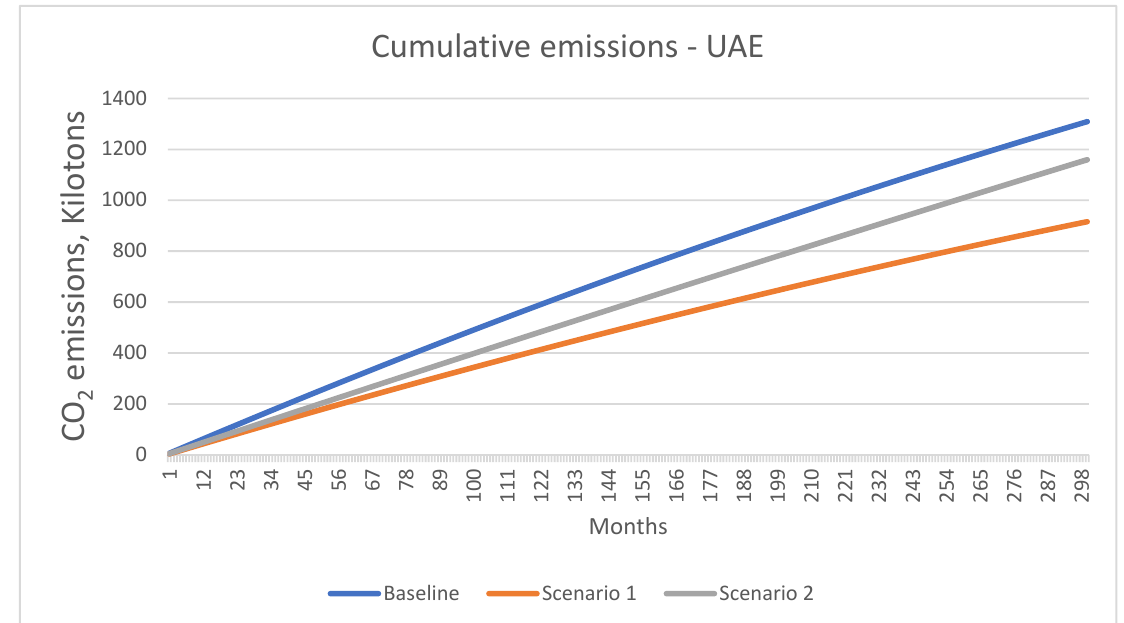
Figure 13. Comparison of emissions through electricity consumption under different scenarios in a reference cement plant in UAE.